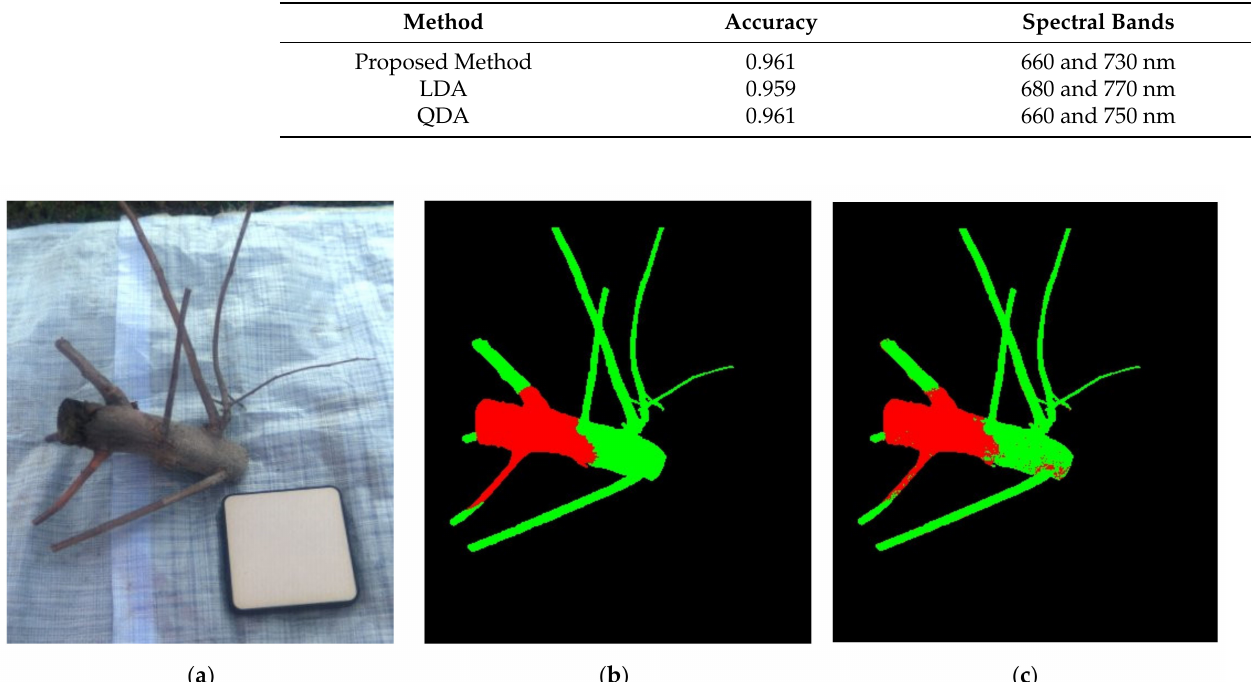
Figure 6. ( a ) A composite color image created from hyperspectral imaging; ( b ) the ground-truth image and ( c ) the discrimination result. Pixels of healthy and diseased parts are indicated by green and red colors,